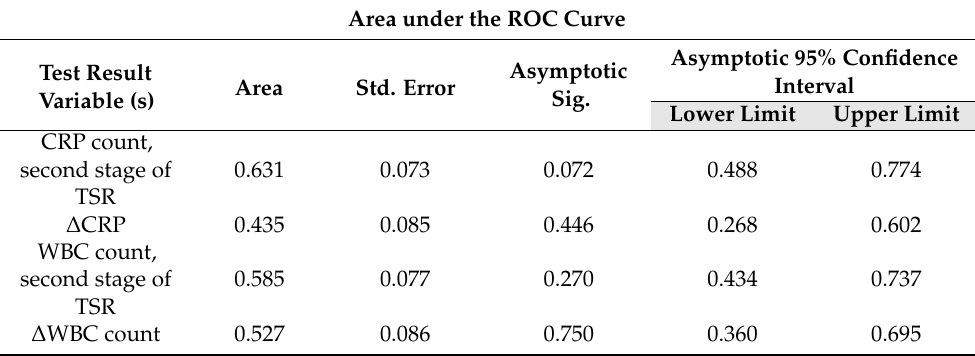
Figure 3. Receiver operating characteristic curves for CRP values sampled prior to the second stage of TSR (CRP second stage) and ∆ CRP (CRP second stage minus CRP first stage of TSR). Table 2. The test result variables: CRP second stage of TSR, WBC count second stage of TSR, ∆ WBC count have at least one tie between the positive actual state group and the negative actual stage